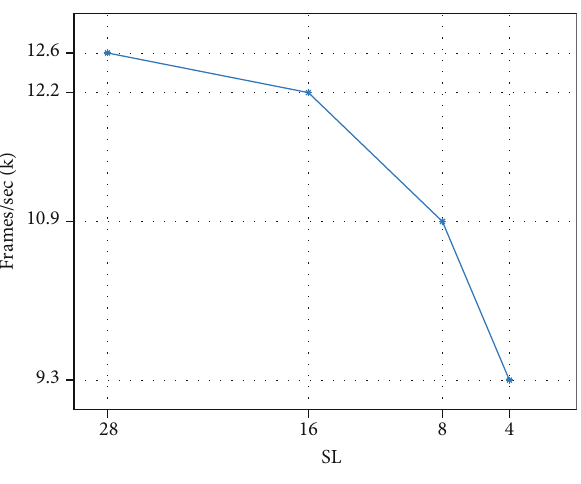
Figure 11: LBP frame